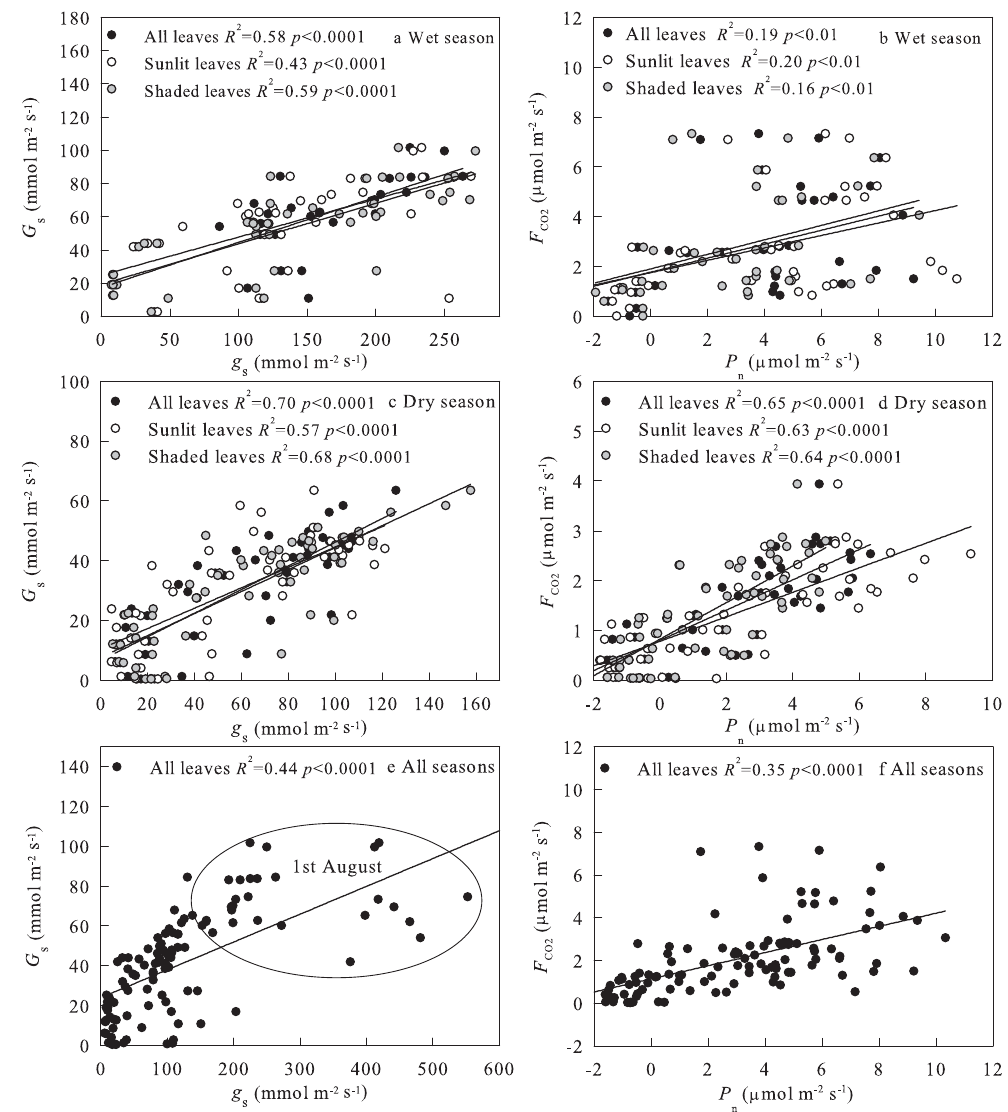
Fig. 6. Scatter plots of leaf stomatal conductance ( g s ) vs. canopy stomatal conductance ( G s ) , and leaf net photosynthesis ( P n ) vs. canopy CO 2 uptake ( F CO ) in (a, b) the wet season (9 and 10 May, 26 July), (c, d) the dry season (6 and 7 November, 6 and 17 December), and (e, 2 f) all seasons (9 and 10 May, 26 July, 1 August, 6 and 7 November, 6 and 17 December). The data in the ellipse in (e) occurred on 1 August (see text for further explanation). All regressions were highly significant ( p < 0 . 01). Data were obtained by the SF/SI approach and leaf gas exchange